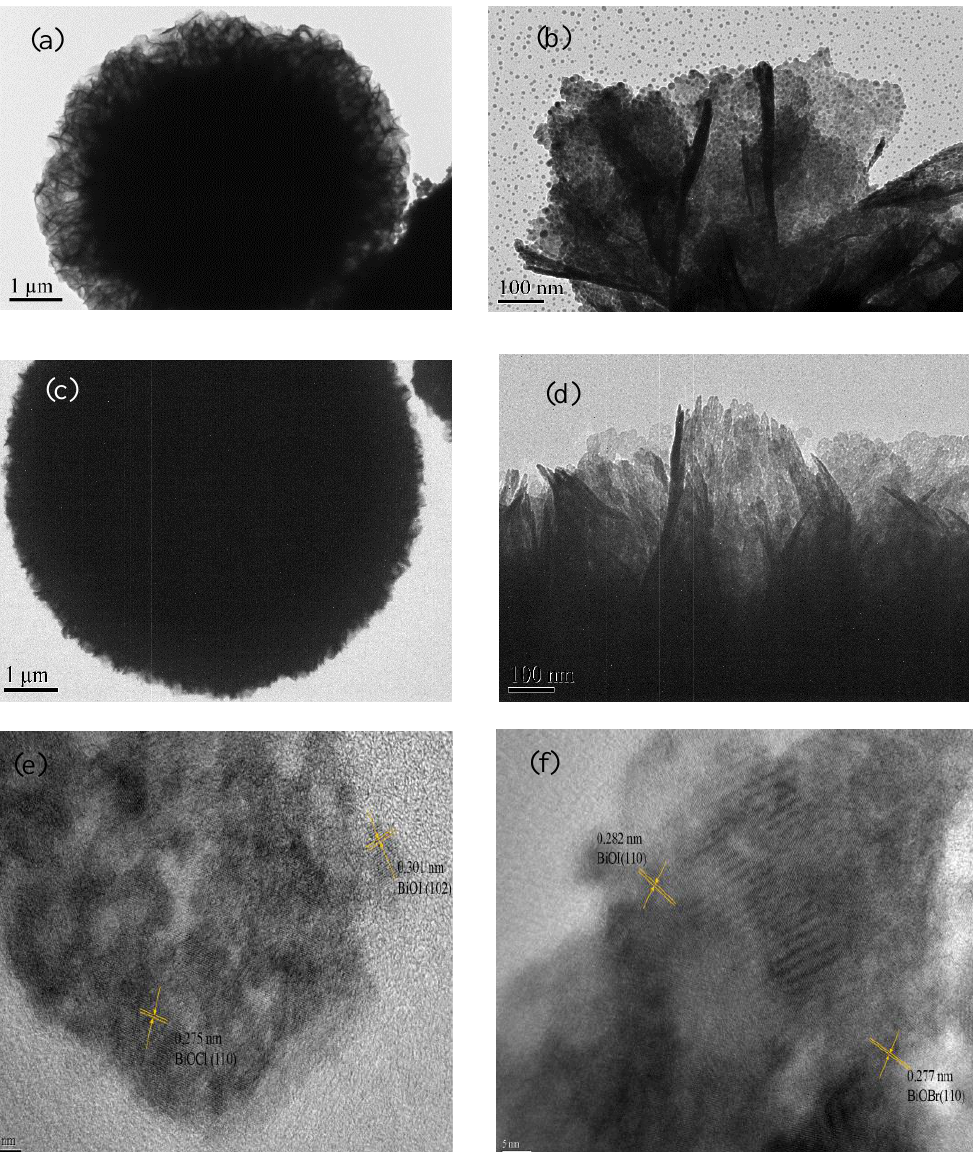
Figure 3. Transmission electron microscopy (TEM) images of ( a , b ) BiOI/ BiOCl; ( c , d ) BiOI/ BiOBr samples and high resolution transmission electron microscopy (HRTEM) images of ( e ) BiOI/BiOCl; ( f ) BiOI/BiOBr.